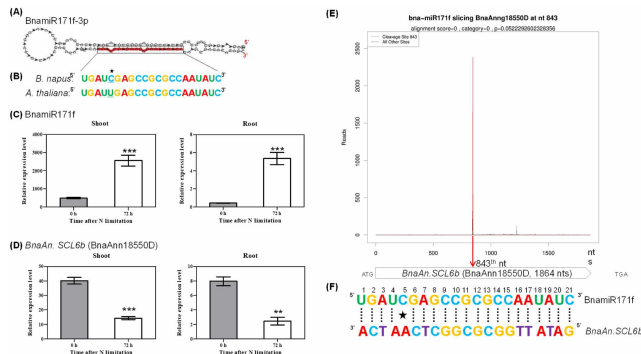
Figure8. Molecular identification of thecleavage of SCL6 by miR171 regulating root growth. ( A ) Hairpin structures and mature sequences of Bna-miR171f. The mature miRNA sequence was marked with red color. ( B ) Mature sequence alignment of Bna-miR171f between Arabidopsis thaliana and B. napus . The asterisk indicates the G:U pair. ( C , D ) Quantitative RT-PCR results showing relative expression levels of Bna-miR171f ( C ) and its target gene BnaAn.SCL6b (BnaAnn18550D) ( D ) in the shoots and roots under N su ffi ciency (0 h) and N limitation (72 h). Bars denote means ( n = 3), and errors bars indicate standard deviation. Columns denote means ( n = 3), and error bars indicate standard deviations. **, p < 0.01; ***, p < 0.001; ns, not significant. ( E ) Target plot (t-plots) of representative Bna-miRNA171 targets confirmed by degradome sequencing. The red lines showed the distribution of the degradome tags along the target mRNA sequences. The red arrow represented the cleavage nucleotide positions on the target gene. The x -axis indicates the nucleotide position in the target cDNA, and the y -axis indicates the number of reads of cleaved transcripts detected in the degradome cDNA library. Alignment score is the score for mismatch. Score = 0 represents perfect match and G:U = 0.5. ( F ) Sequence matching between the mature sequence of BnamiR171f and its target gene BnaAn.SCL6b . The asterisk indicates the G:U pair.